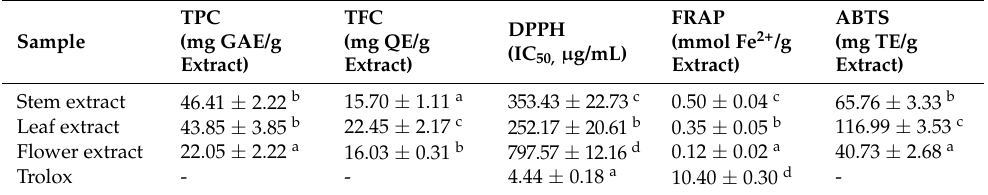
Table 1. Total phenolic and flavonoid contents and antioxidant activities (DPPH, FRAP and ABTS assays) of ethanolic extract of D. sulcatum stems, leaves and